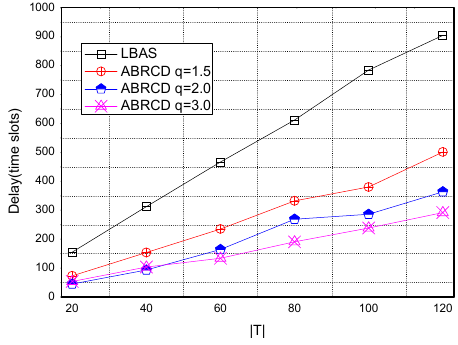
Figure 42. The impact of | T | with fixed network size = 1000 on delay.